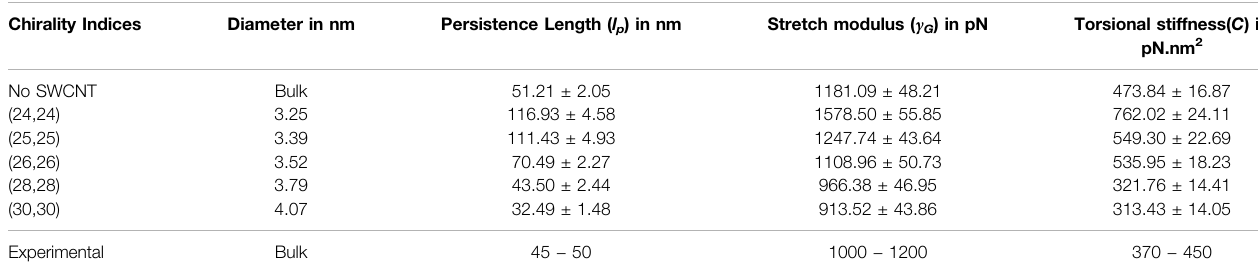
TABLE 3 | Persistence length, stretch modulus, and torsional stiffness of the con fi ned